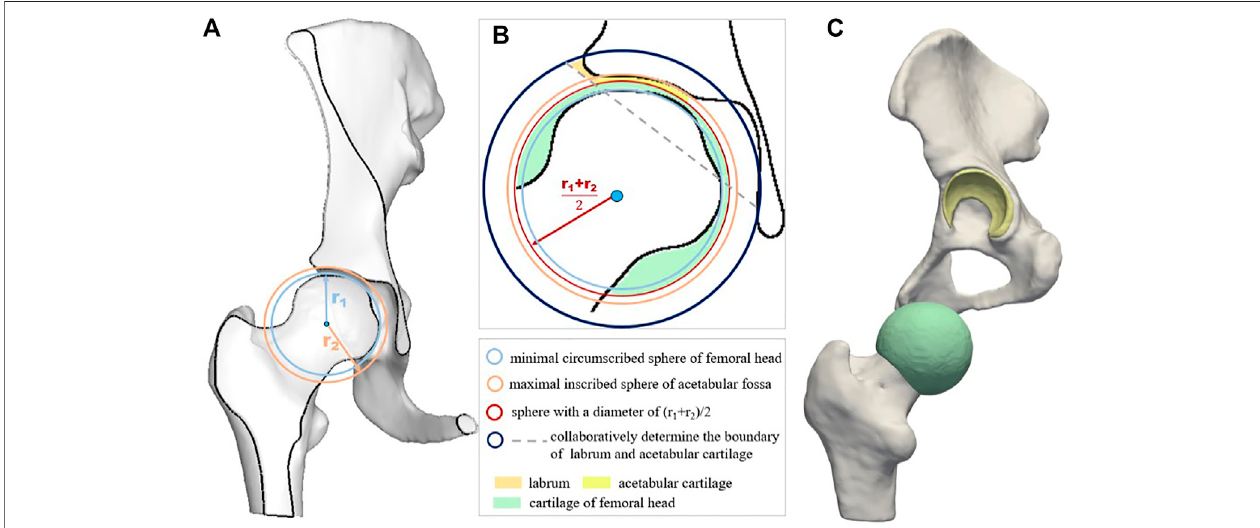
FIGURE2 | Schematic diagram ofcartilage construction methodincluding acetabularcartilage, cartilage offemoralhead,and thelabrum. (A) displays theminimal circumscribed sphereofthe femoralhead and the maximal inscribed sphere ofthe acetabular fossa; (B) isthe schematic diagram ofcartilage construction method; and (C) shows the geometric models of the cartilage layers.